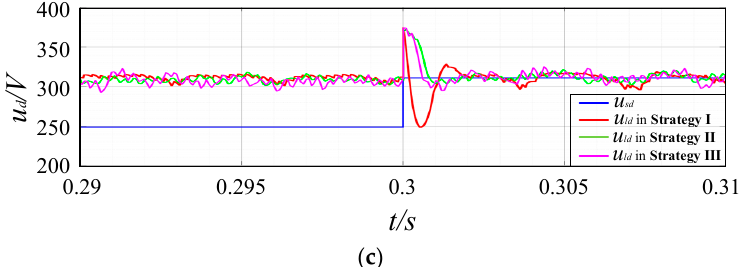
Figure 11. Voltage details at change in working conditions. ( a ) Instantaneous grid voltage swell; ( b ) instantaneous grid voltage sag; ( c ) instantaneous sudden changes in load.